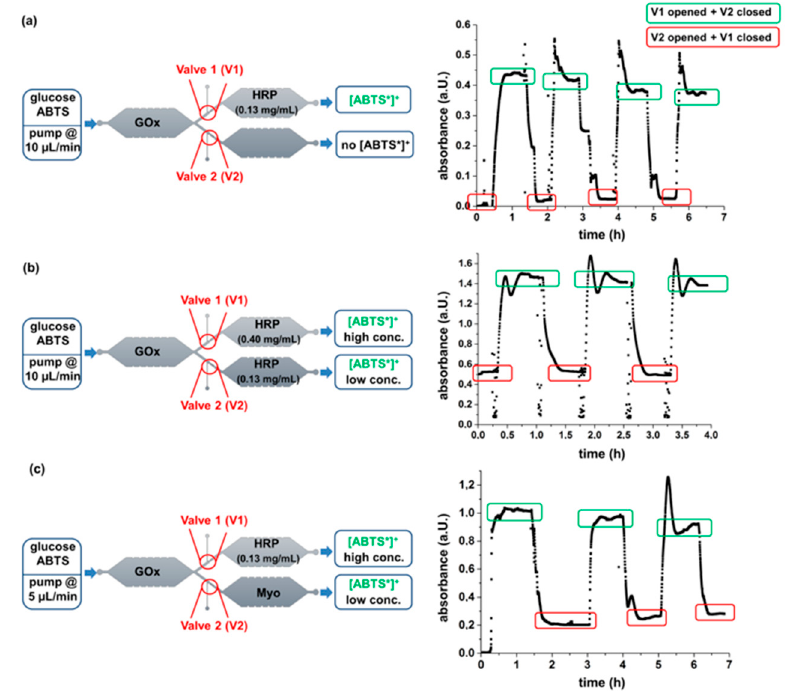
Figure 7. Schemes of enzymatic reaction performed in microfluidic devices with an ABTS/glucose substrate solution (5 mmol/L) (left) and results of the corresponding continuous UV-Vis measurements (right). ( a ) Microfluidic device with only GOx and HRP, ( b ) Microfluidic device with GOx and two different amounts of HRP, ( c ) Microfluidic device with GOx, HRP, and Myo. Three ( b , c ) or four ( a ) switching cycles of the microvalves were performed. The flow rate of only 5 µL/min in experiment ( c ) was chosen because of the low activity of Myo. The UV-Vis measurement was performed offline and thus changes of the absorbance occurred with a timely delay of 15 min with respect to the time point of the switching.